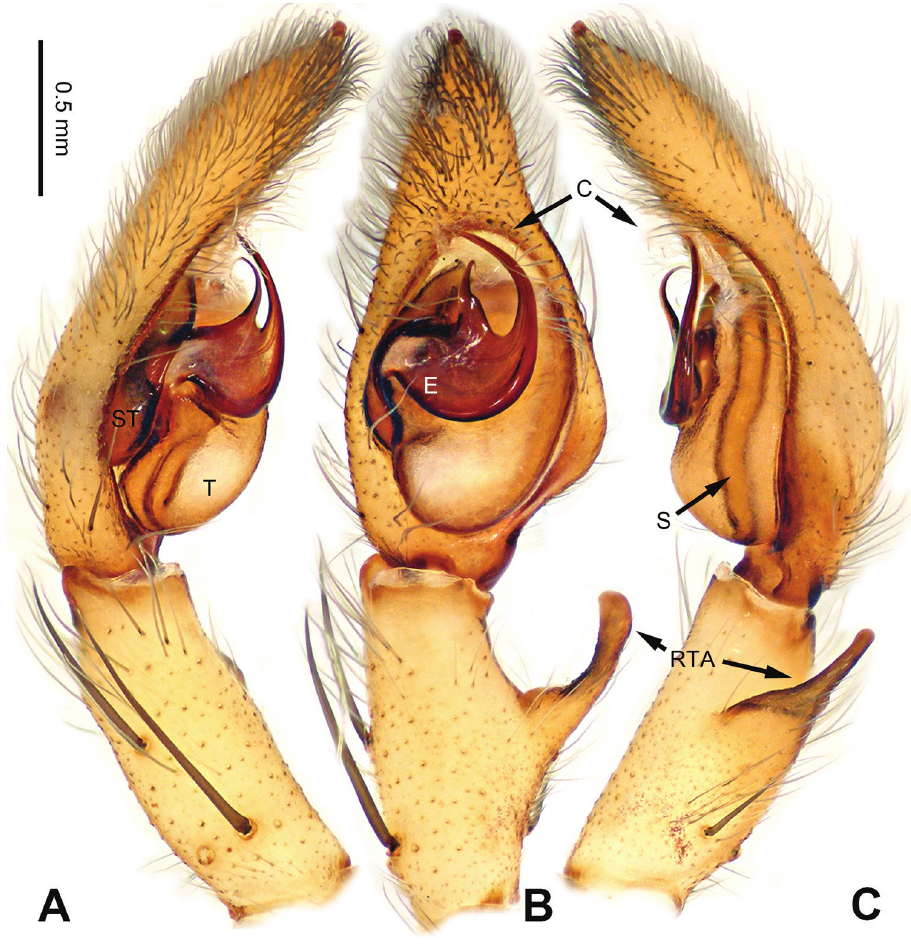
Figure 20. Pseudopoda shacunensis Zhao & Li, sp. n., left palp of male holotype. A Prolateral view B Ventral view C Retrolateral view. Scale bar equal for A, B, C